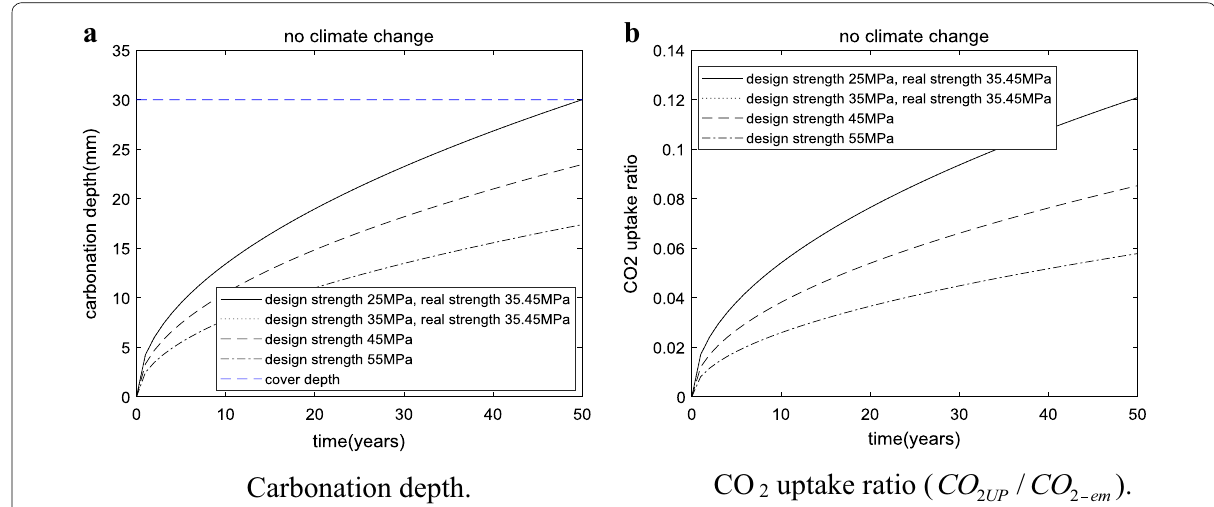
Fig. 4 Carbonation depth and CO 2 uptake under a no climate change scenario.